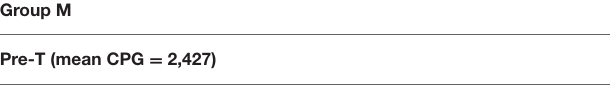
TABLE 4 | Results of mean Giardia cyst per gram (CPG) and efficacy (%) of the treatments performed in Group F, on study days (SDs) 7–12 and SDs 19–20. Group F